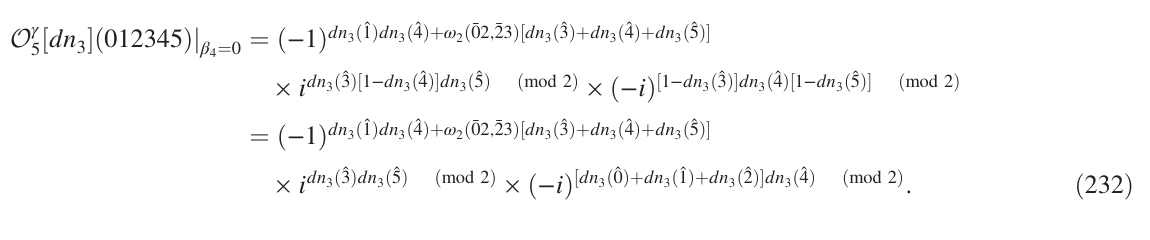
dn 3 ð ˆ 1 Þ P 5 γ ¯02 345 B Þ